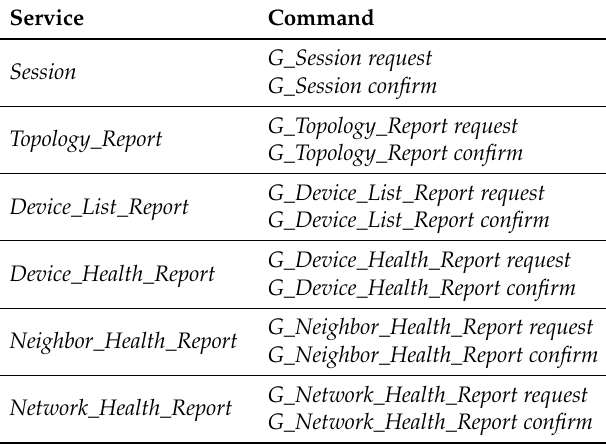
Table 4. GSAP services.